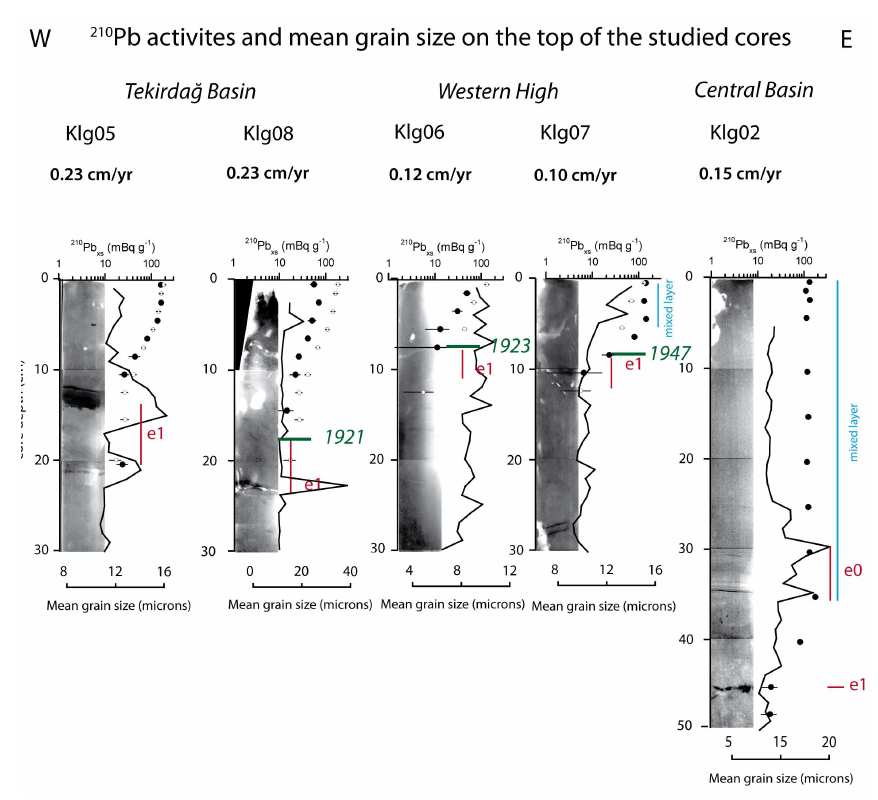
Fig. 7. Excess 210 Pb activities (black dots) and computed sedimentation rates of the cores Klg02, Klg05, Klg06, Klg07 and Klg08. White dots are from nearby ROV cores and show that no significant loss of sediments occurs in Klg cores. The extent of the mixed layer is depicted in blue. X-ray imagery associated with the mean grain size (black lines) shows the location of the e1 sedimentary event induced by the M = 7 . 4 1912 earthquake. The age model derived from 210 Pbxs at the top of the 1912 turbidite is represented in green. Data are given in the Appendices. The event e1 has the following characteristics: In Klg05, e1 is marked by two basal sandy layers at 13 and 21cm depth, suggesting two distinct mass flows. The thickest upper one is visible with the naked eye and is associated with a significant increase in zirconium and titanium content (Fig. 4). In Klg08 similar sandy layers and geochemical signatures are observed at 18cm and 23cm depth. In Klg07, the event is marked at 10–11cm by a small sandy peak, a step increase in silt and an increase in Ti and Mn in XRF record. In Klg06, there is a similar step increase in silt, associated with a dipping white line in the X-ray.